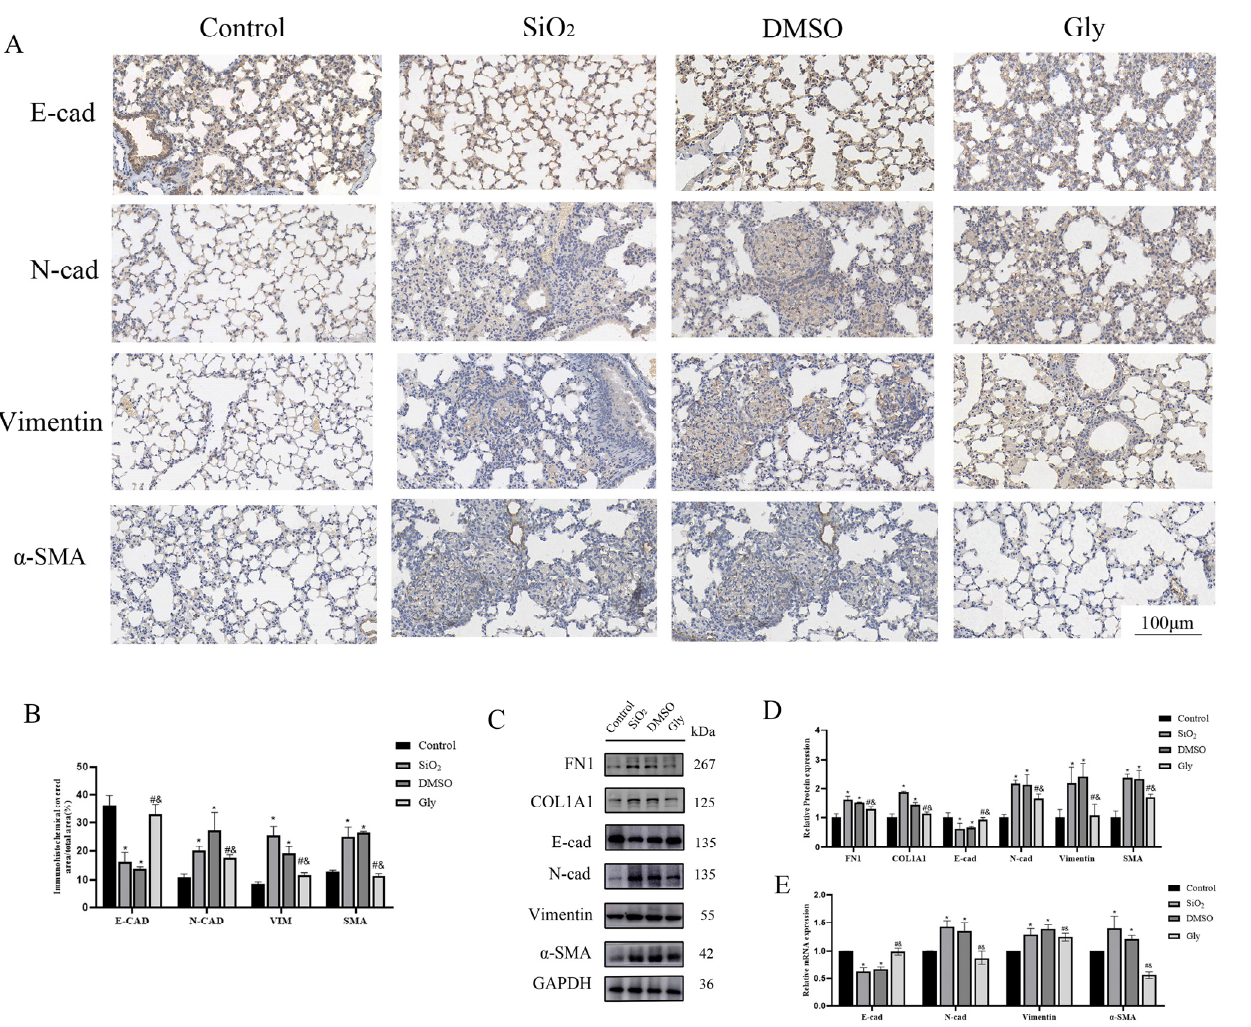
Figure 7. Glycyrrhizic acid inhibits the process of EMT. ( A ) IHC staining showing E-cad, N-cad, Vimentin, and SMA expression in these four groups respectively. ( × 200). Scale bar = 100 µ m. Blue indicates the location of the nucleus and brown indicates the expression of specific proteins. ( B ) Quantification. ( C , E ) The expression of FN-1, COL-1, E-cad, N-cad, Vimentin, α -SMA, and GAPDH were detected by Western blotting and RT-qPCR. ( D ) Quantification. Shown are the averages of three independent experiments. GAPDH was used as an internal control *: p < 0.05 compared with the control group; #: p < 0.05, compared with the SiO 2 group; &: p < 0.05, compared with the solvent control